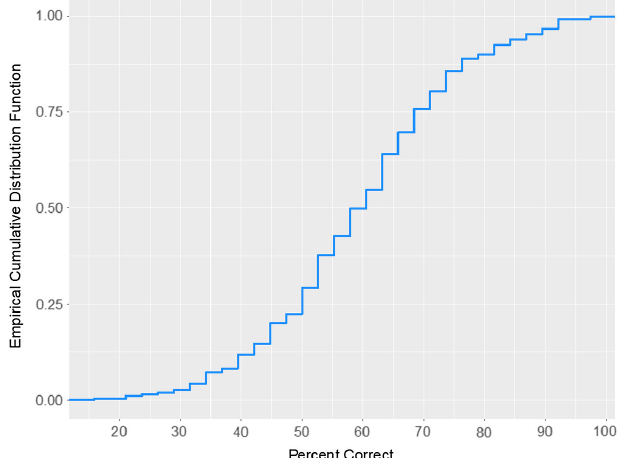
FIG. 1. The empirical cumulative distribution function displays the percent correct on the QMCA on the x axis and the percent of the sample with that score or less on the y axis. The data have a slight right skew, but are approximately